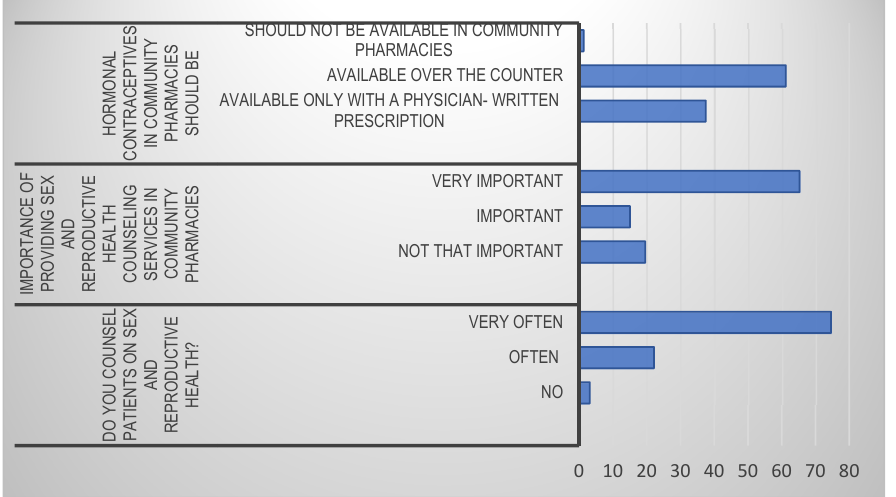
Figure 1. View of community pharmacists’ perception on providing counselling services on sex and reproductive health.